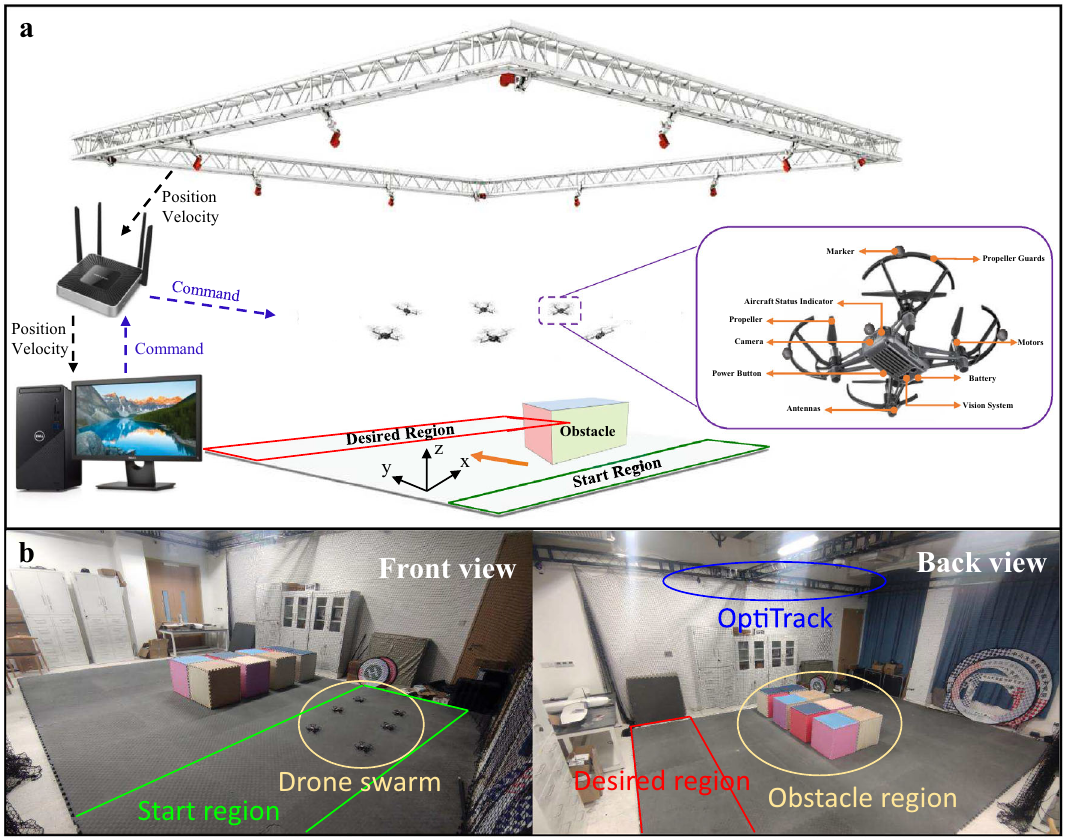
Fig. 9 Configuration of physical flight platform based on motion cap- ture. a The platform consists of six DJI Tello drones, a ground control station, a router for building a local area network, and OptiTrack opti- cal motion capture cameras. The hardware composition of the drone is shown in the purple block diagram. Some drones equipped with task